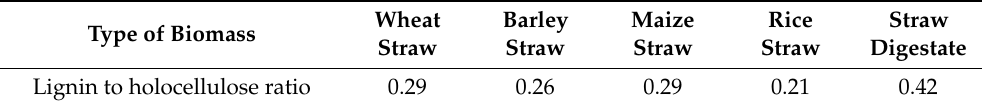
Wheat Barley Maize Rice Straw Straw Straw Straw Straw Digestate